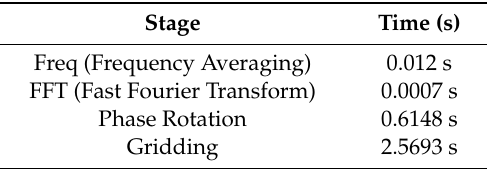
Table 1. Time consumed in various